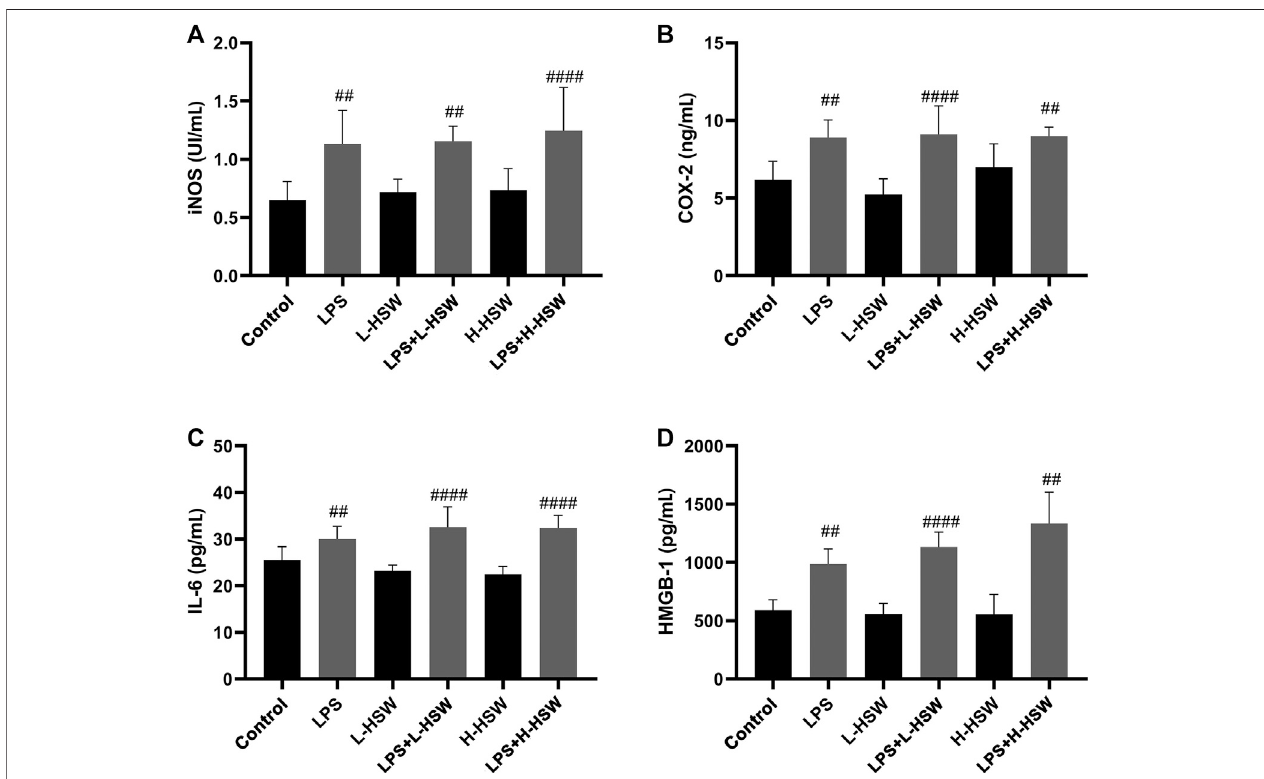
FIGURE3| HistogramsoflevelsofiNOS (A) ,COX-2 (B) ,IL-6 (C) andHMGB-1 (D) ,whichweredeterminedbyusingthecorrespondingELISAassaykits.Eachbar represents the mean ± standard error ( n (cid:2) 6). # p < 0.05, ## p < 0.01, ### p < 0.001, and #### p < 0.0001 comparing with control group. Comparingwith LPS group, LPS + L-HSW and LPS + H-HSW groups did not showed signi fi cant